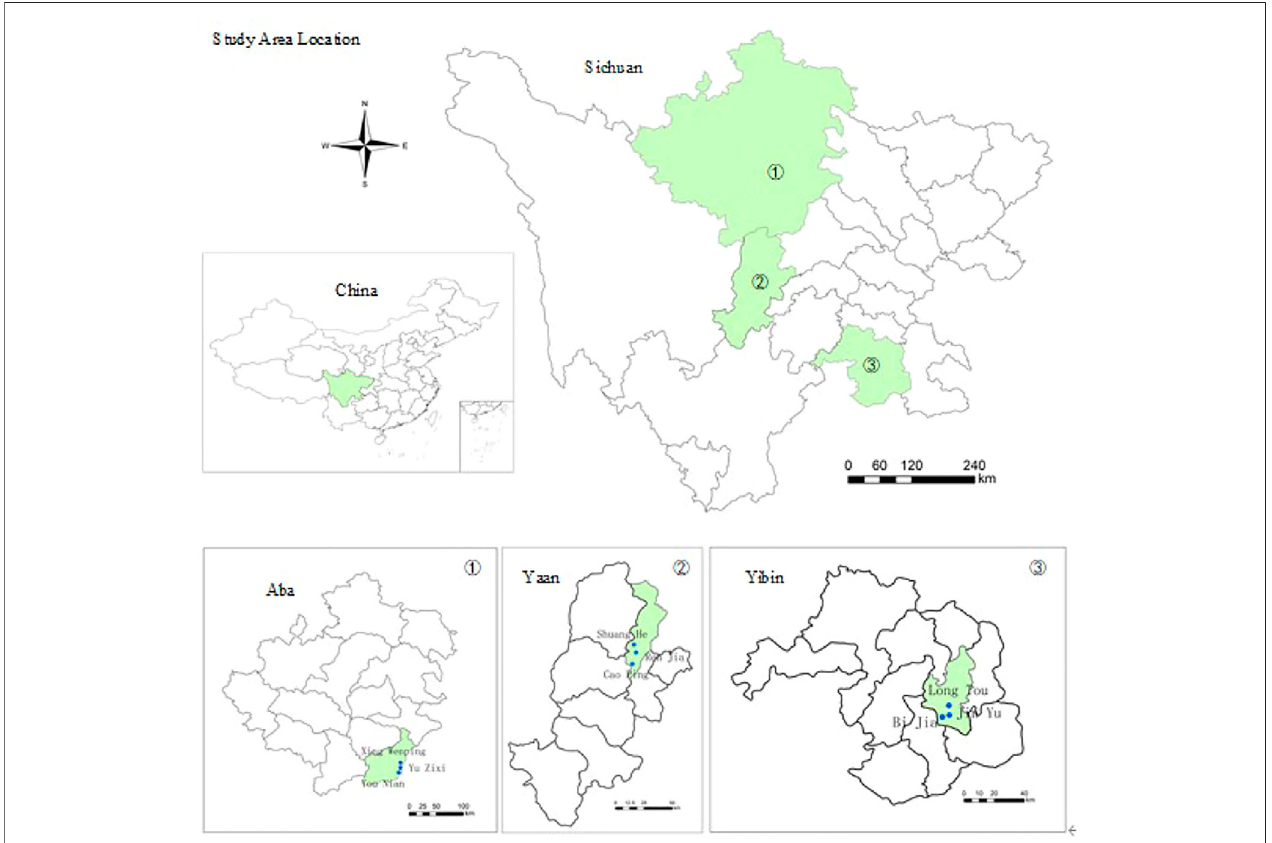
FIGURE 1 | Location of sample